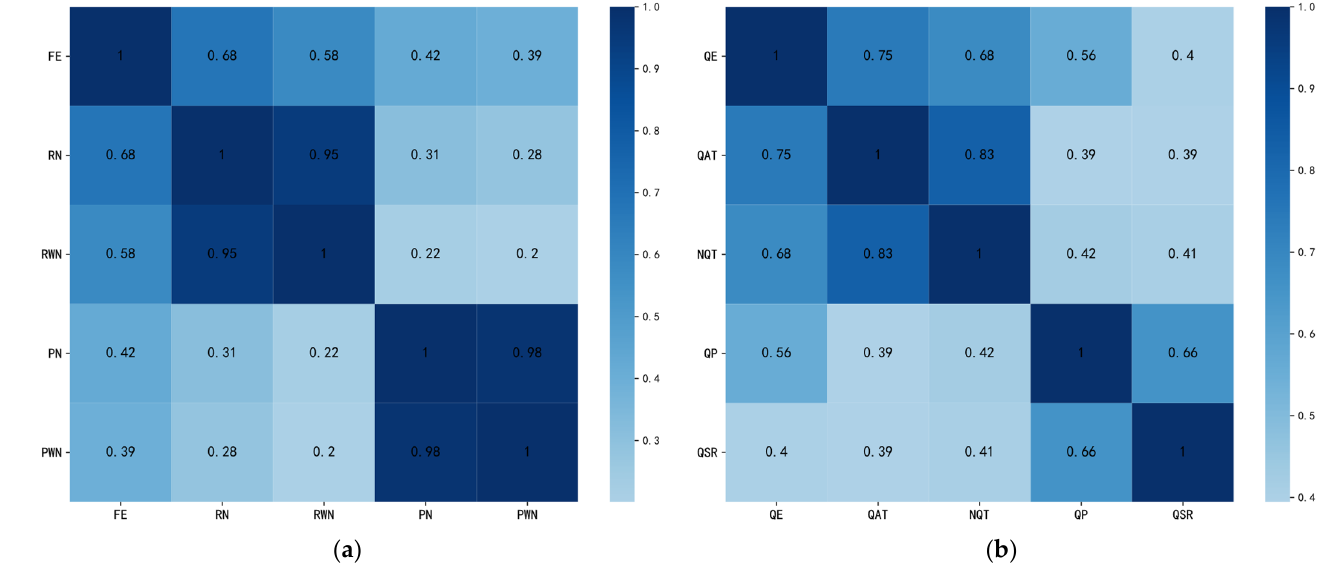
Figure 1. Heat map of two main behaviors: ( a ) forum interaction and ( b ) quizzes submission.